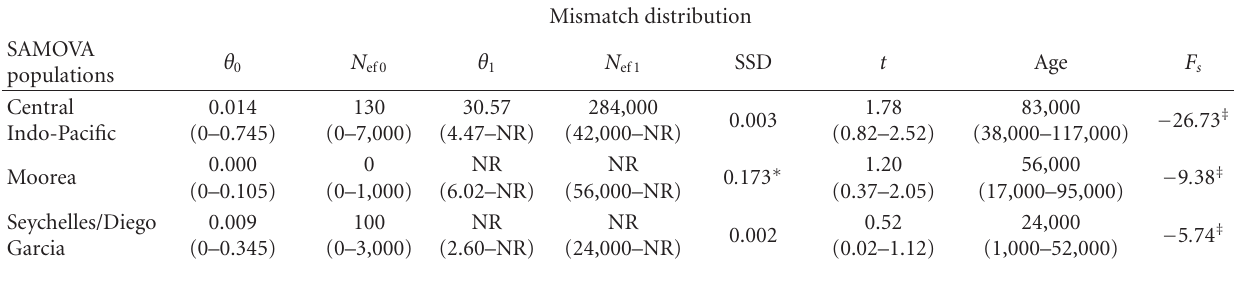
Table 4: Estimates of historical demography including pre- and post-expansion theta ( θ 0 and θ 1 ), female e ff ective population size ( N ef ), mismatch analyses (sum of squared deviations; SSD), tau ( τ ), time since last bottleneck (age in years), and test for population expansion ( F s ), with unresolved values shown as NR. Standard deviations for population parameter estimates are given in parentheses. Significance represented by: ∗ P ≤ . 05, ‡ P ≤ .